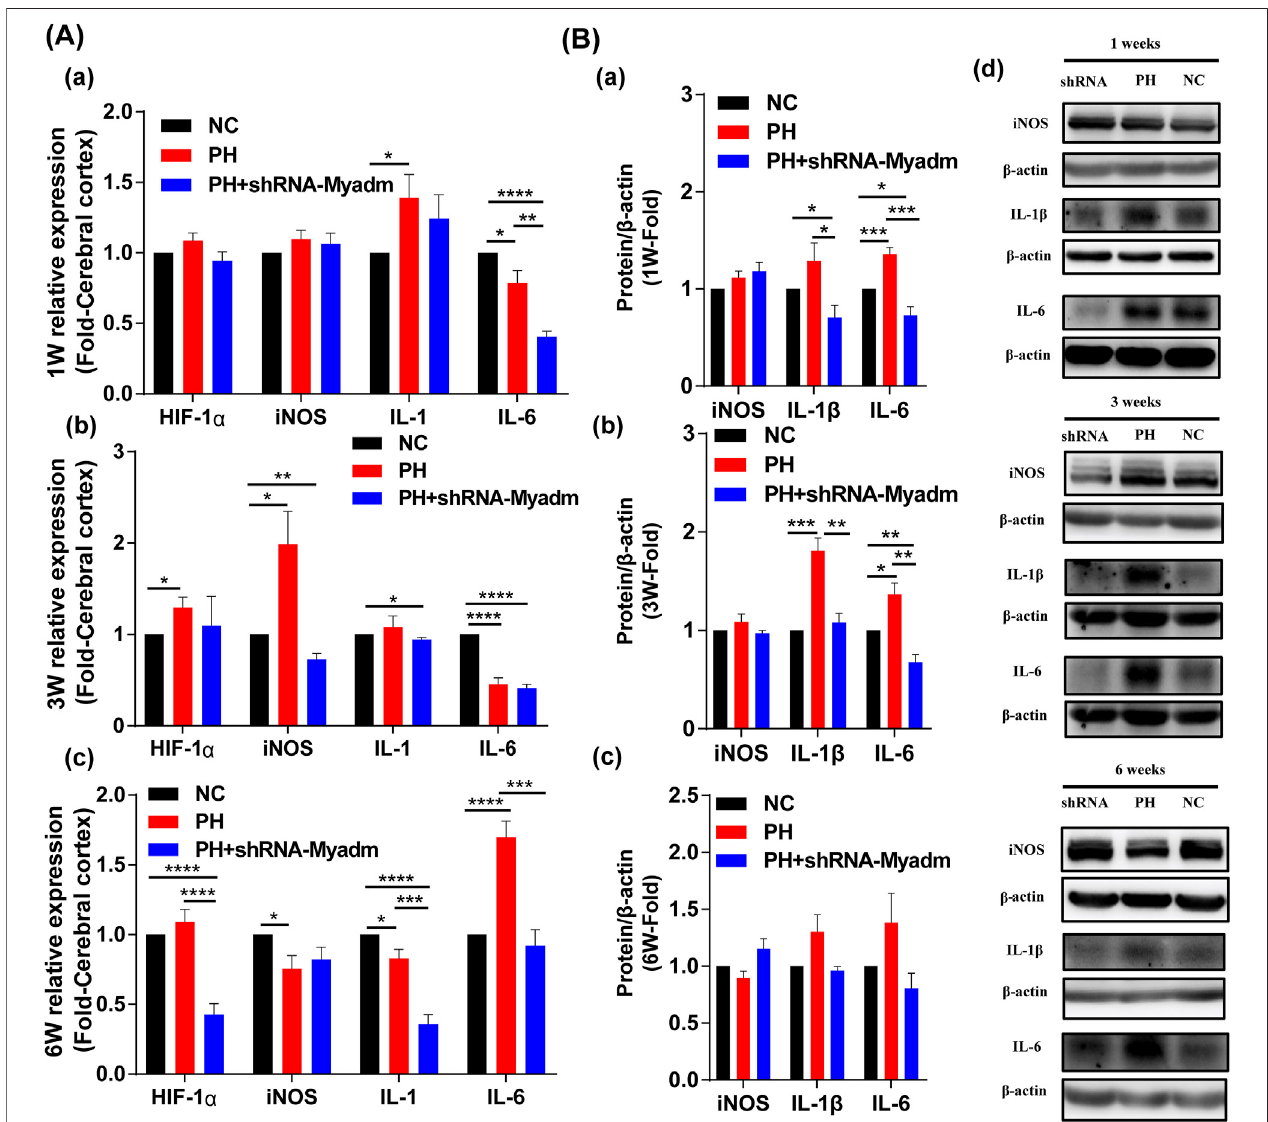
FIGURE 10 | Cerebral hypoxia and in fl ammation in normal, maternal PH, and intervention groups. (A) The mRNA expression of HIF-1 α , iNOS, IL-1, and IL-6 in cerebral of offspring in each group at 1 week of age (a), 3 weeks of age (b), and 6 weeks of age (c). (B) Western blot analysis of iNOS, IL-1 β , and IL-6 in the cerebral of offspringineachgroupat1 weekofage(a),3 weeksofage(b),and6 weeksofage(c).(d)Westernblotstripsofeachgroupatdifferentages.* p < 0.05,** p < 0.01,*** p < 0.001, **** p < 0.0001 vs the normal pregnancy group ( n (cid:1) 5 – 6 rats per group). NC, normal control; PH, pulmonary hypertension.